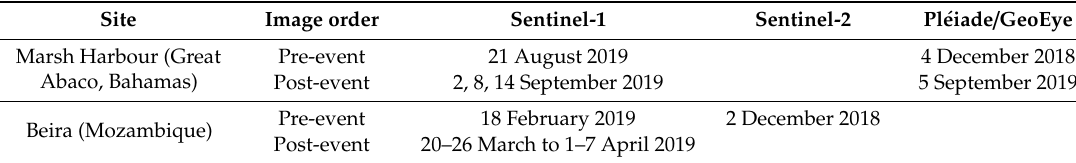
Table 1. Dates of the images used in both study areas.